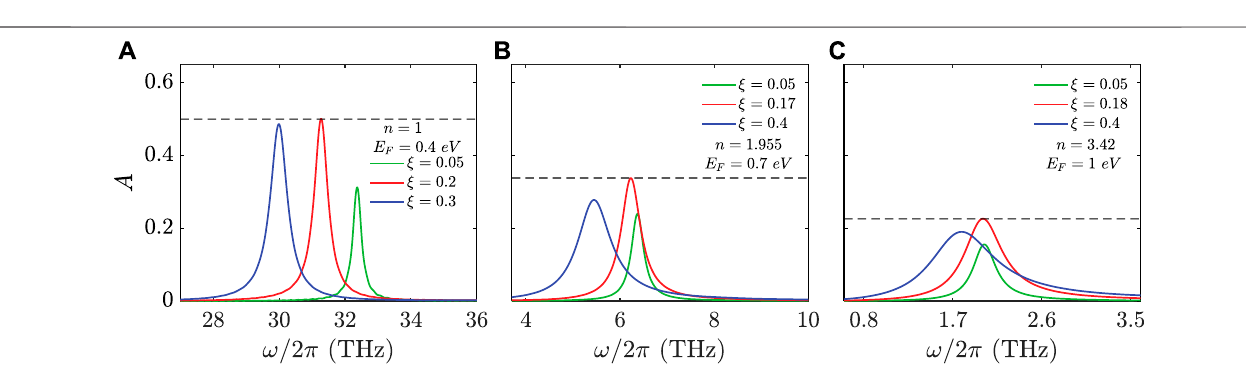
Frontiers in Materials |